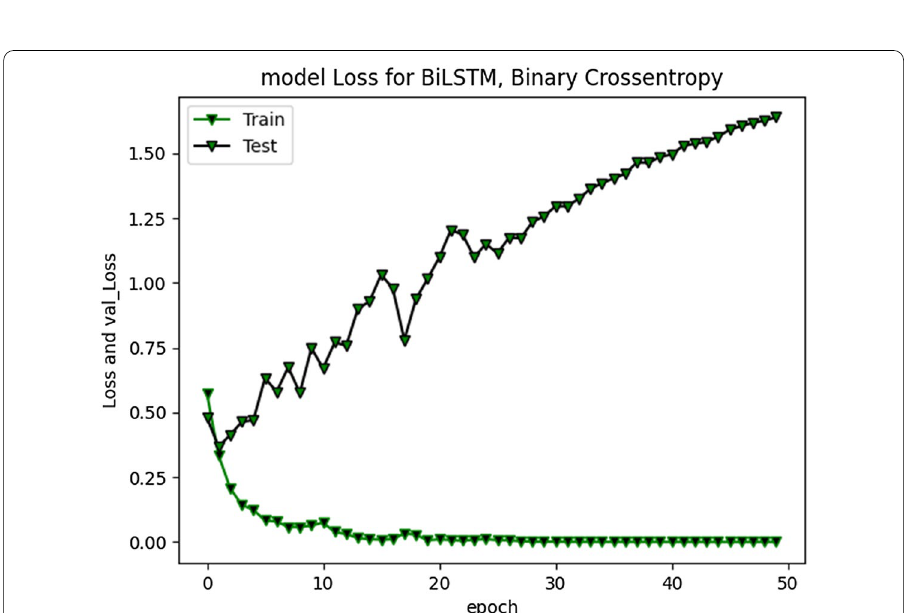
Fig. 13 RNN-BiLSTM Model loss plot- Binary Cross entropy for 50